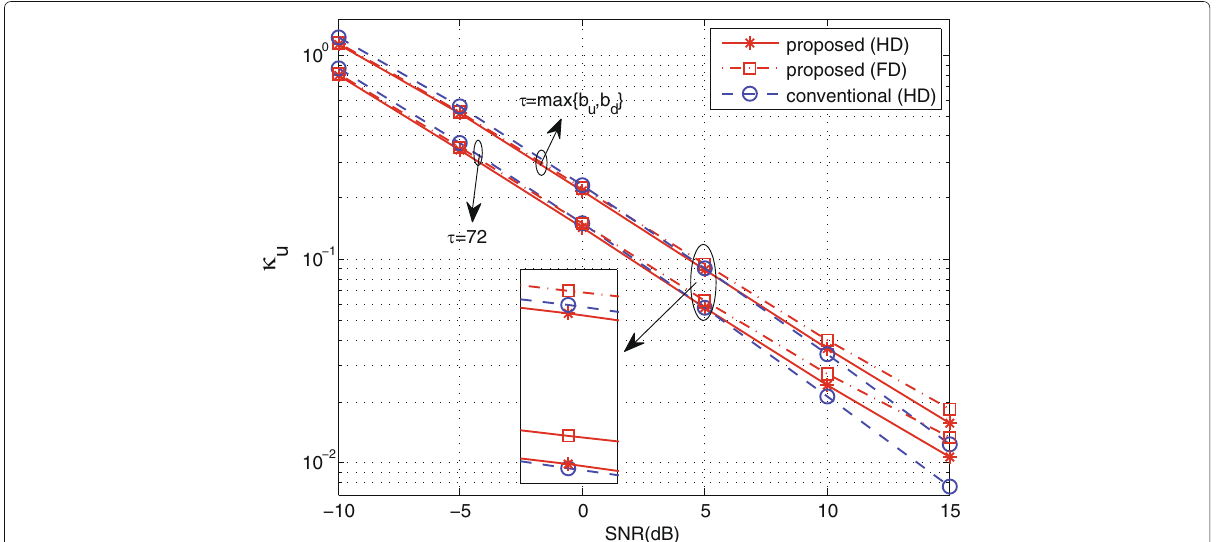
Fig. 4 Comparison of the UL channel estimation performance between the beamspace channel estimation and conventional estimation versus average receive SNRs